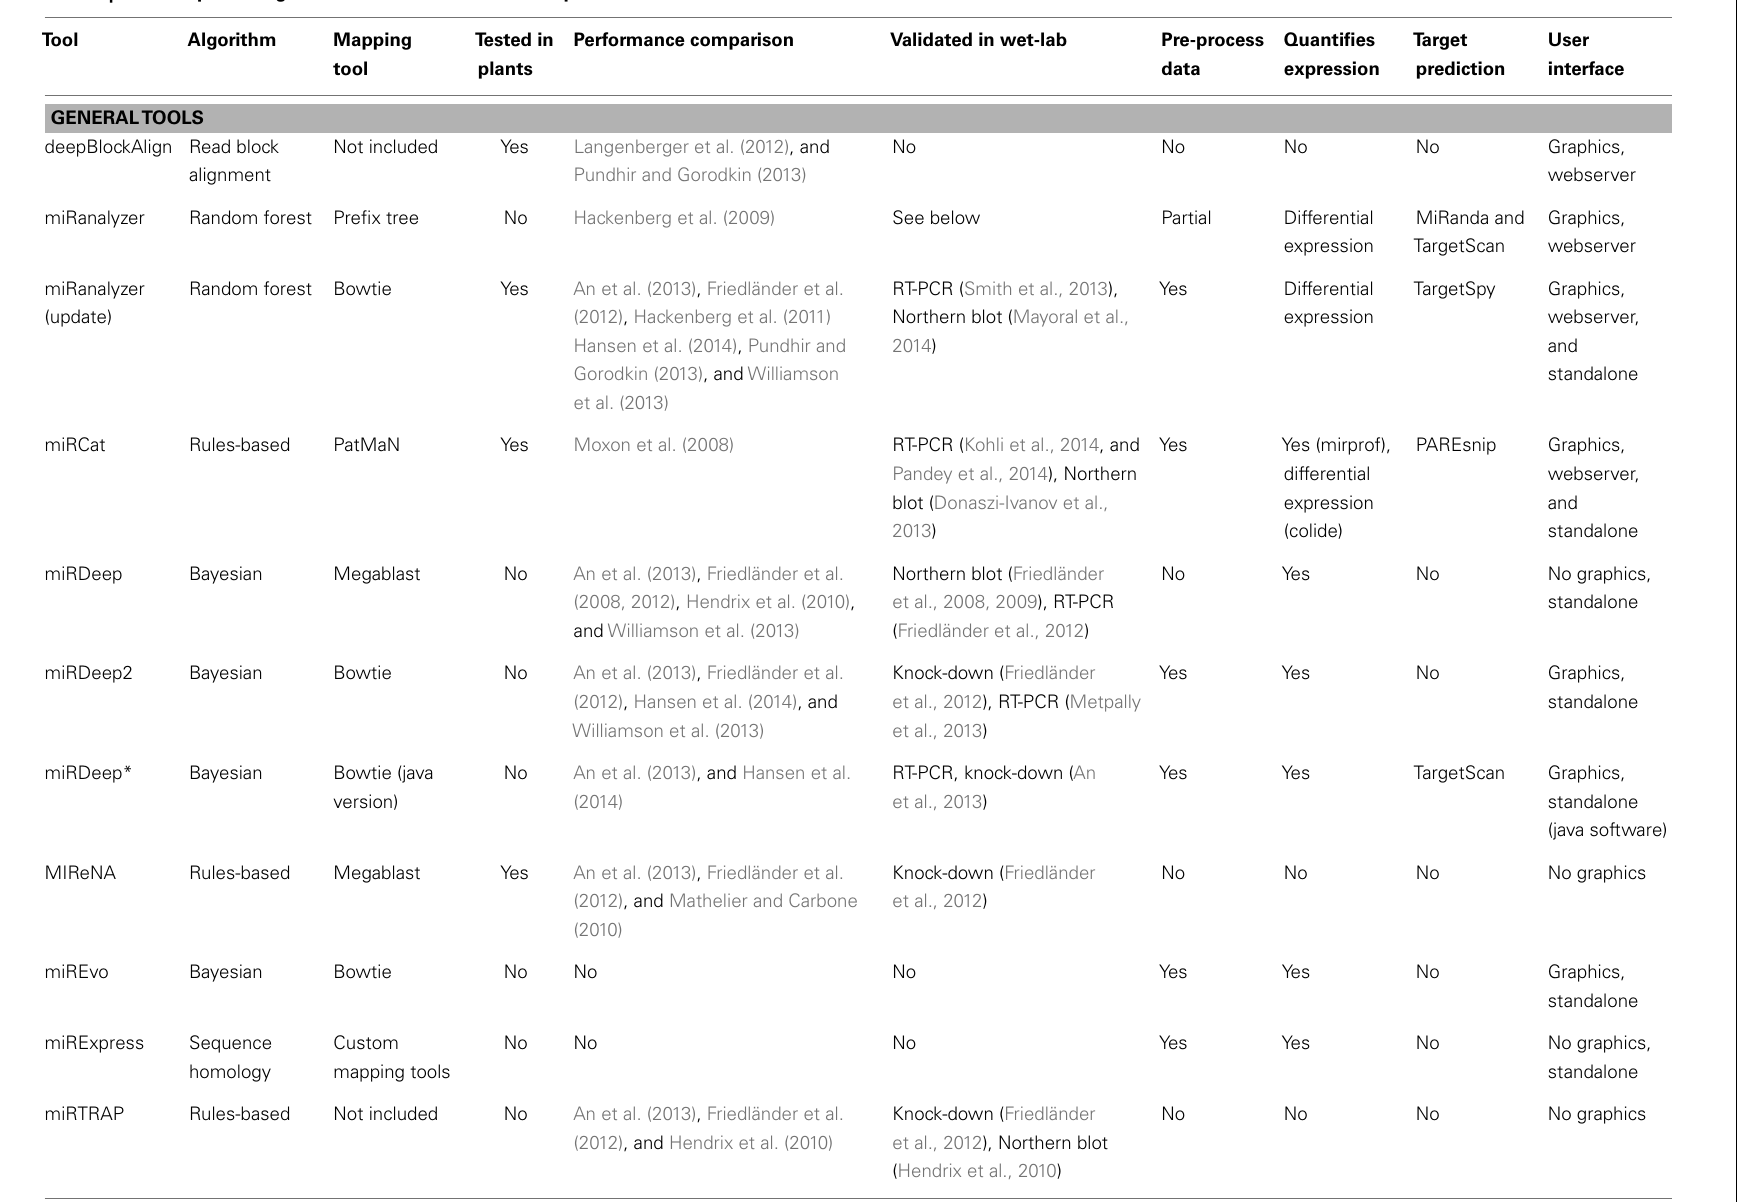
Table 1 |Tools for predicting animal miRNAs from sRNA-seq data